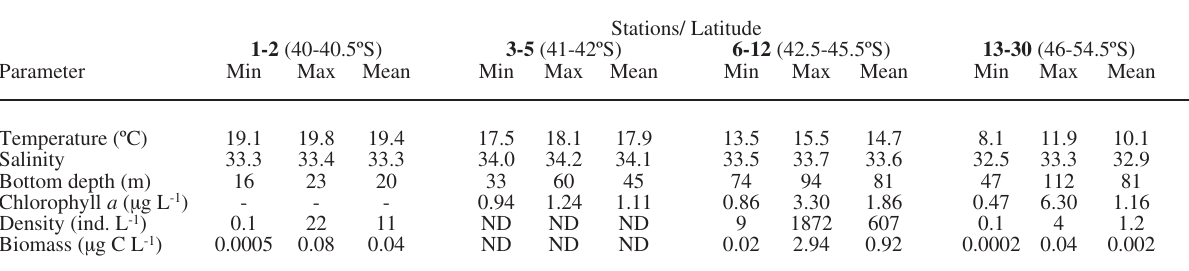
Table 2. – environmental variables and abundance ranges of Helicostomella for groups of stations derived from the Principal component analysis shown in Figure 7. nd: not detected.